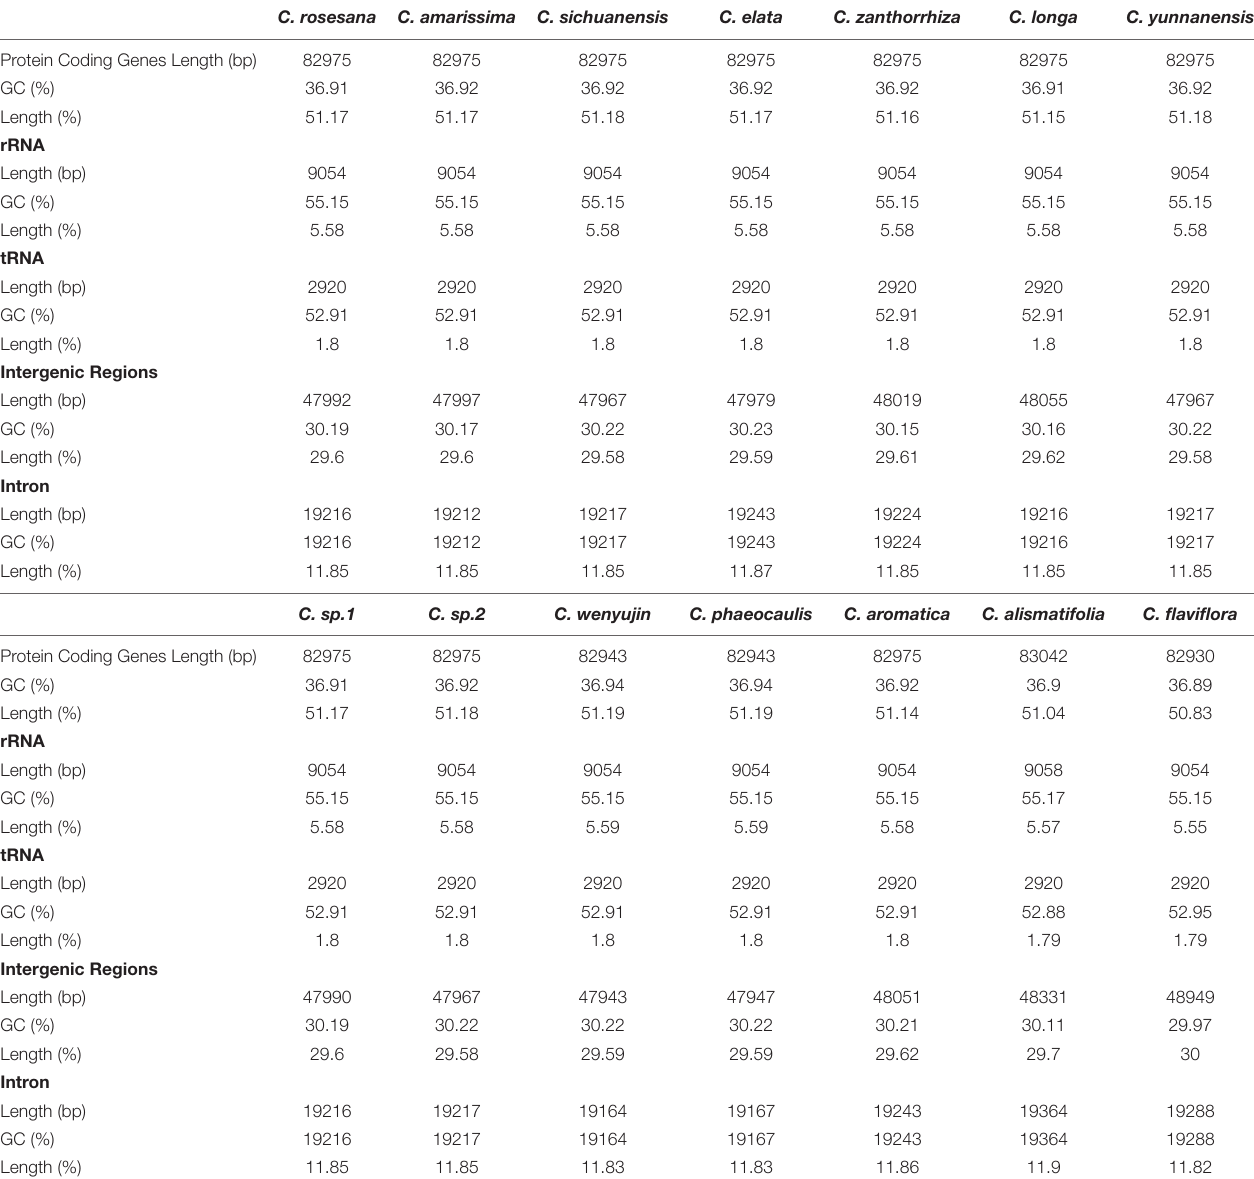
TABLE 3 | Distribution of genes and intergenic regions for 14 species in